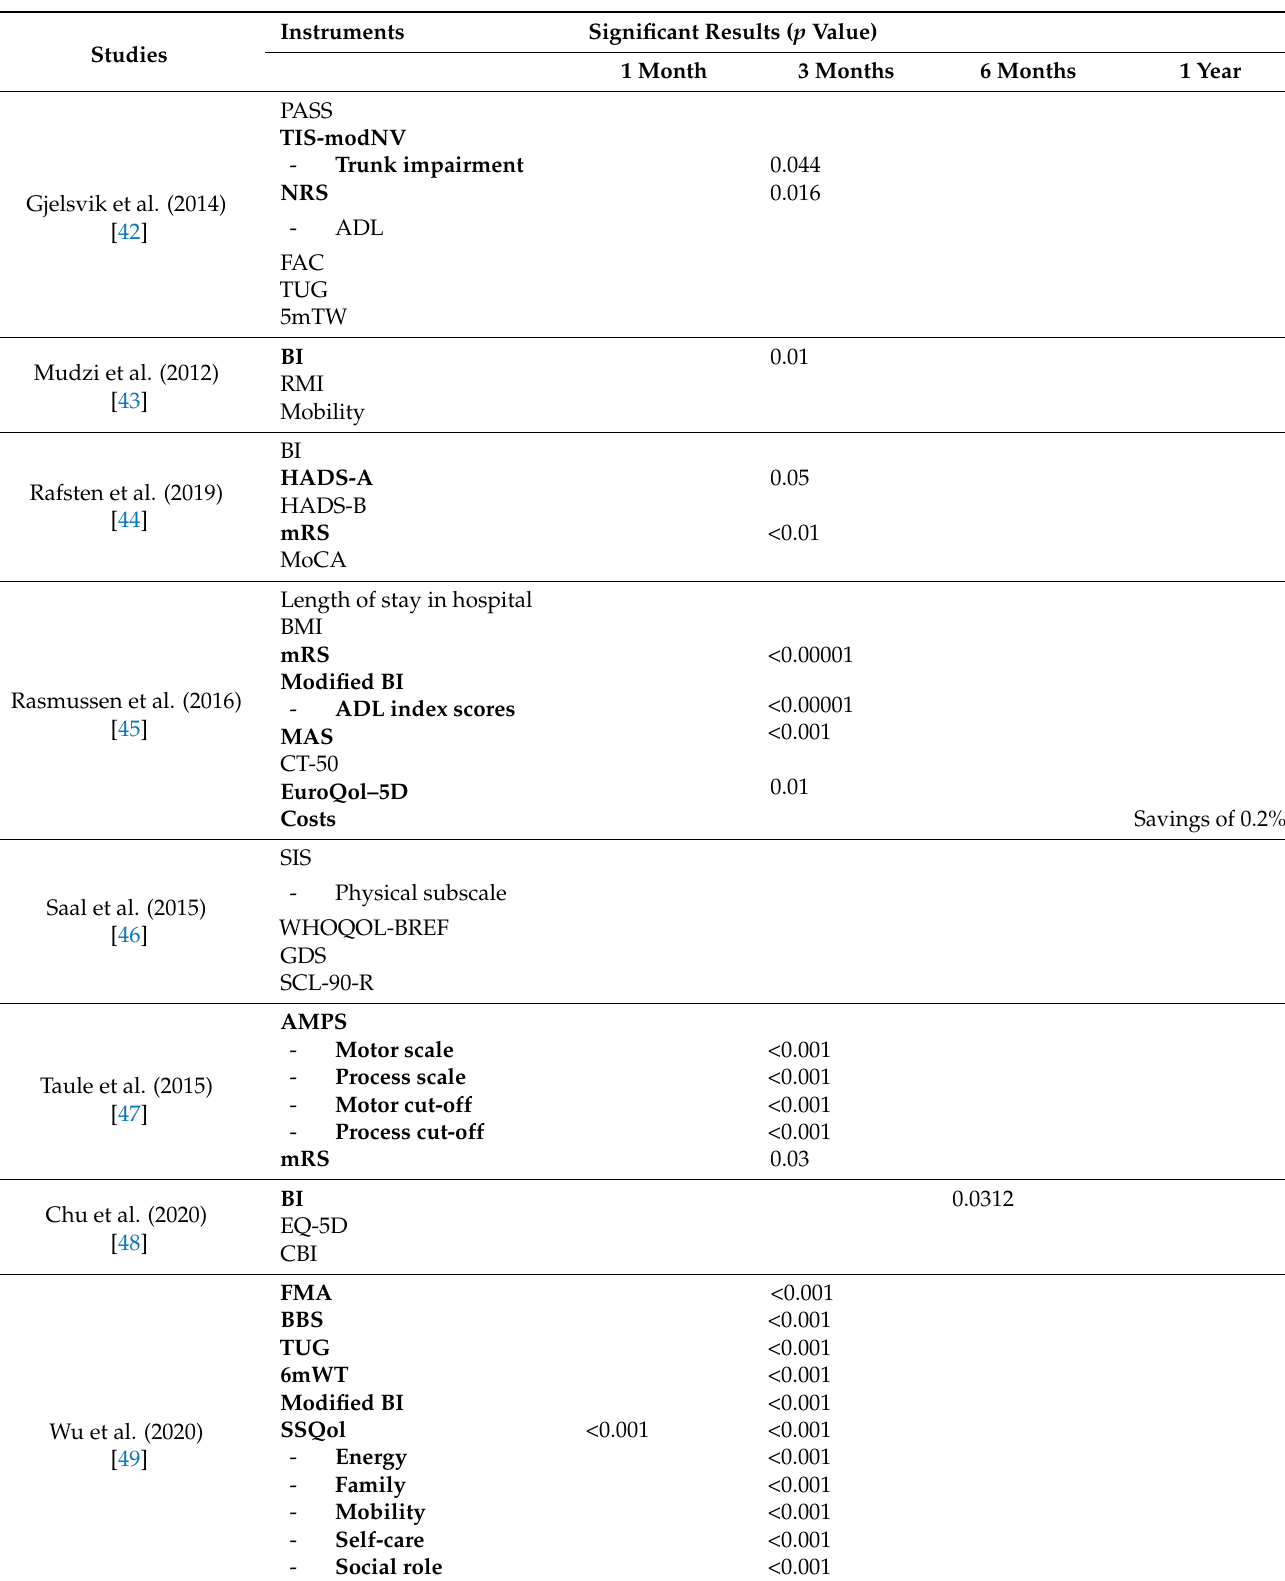
Table 2. Instruments used for evaluations and significant